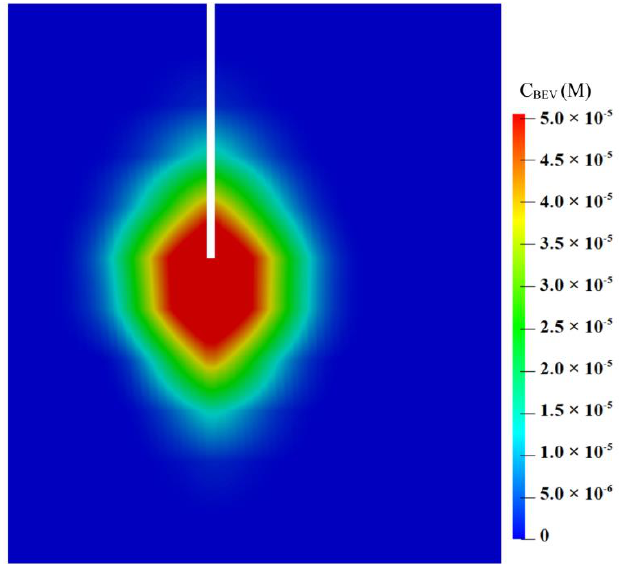
Figure 6. Spatial distribution of BEV on the vertical plane on Day 3.